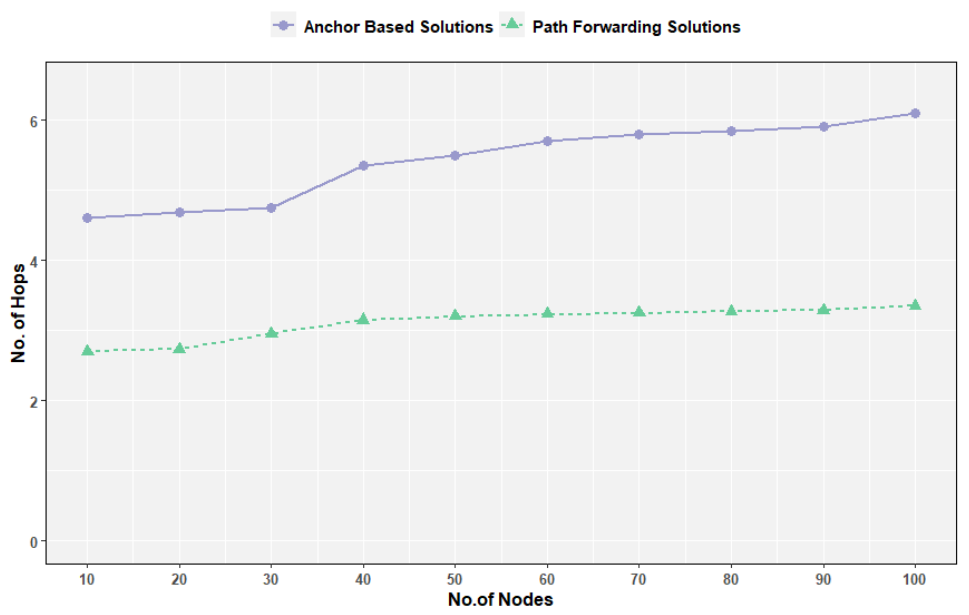
Figure 6. Mean No. of hops for end-to-end packet forwarding in Path Forwarding vs Anchor Based